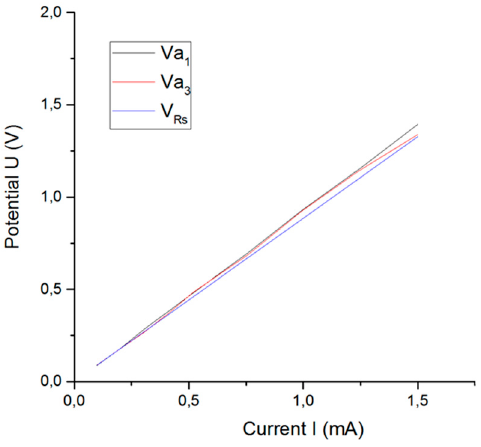
Figure 14. Access voltage as a function of current amplitude of excitation signal.